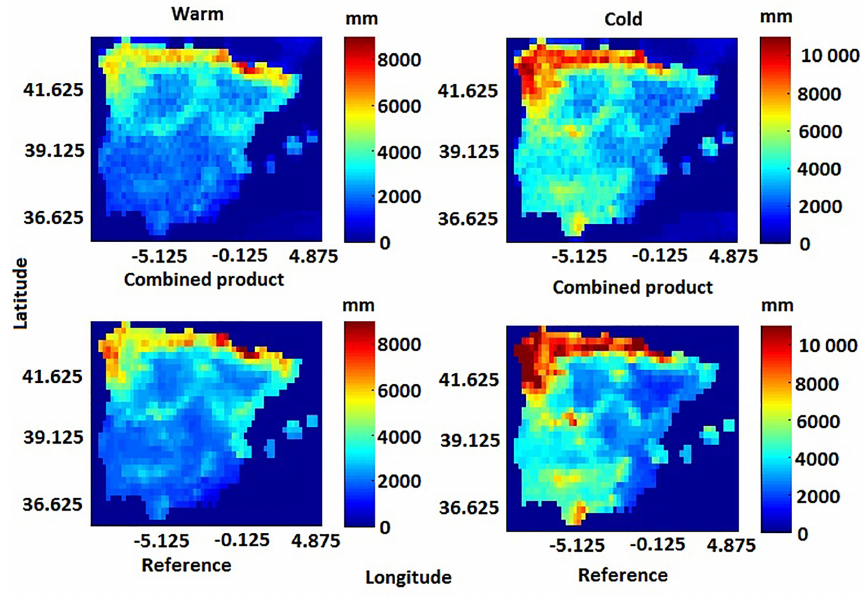
Figure 5. QRF-generated mean ensemble and reference rainfall maps for warm and cold